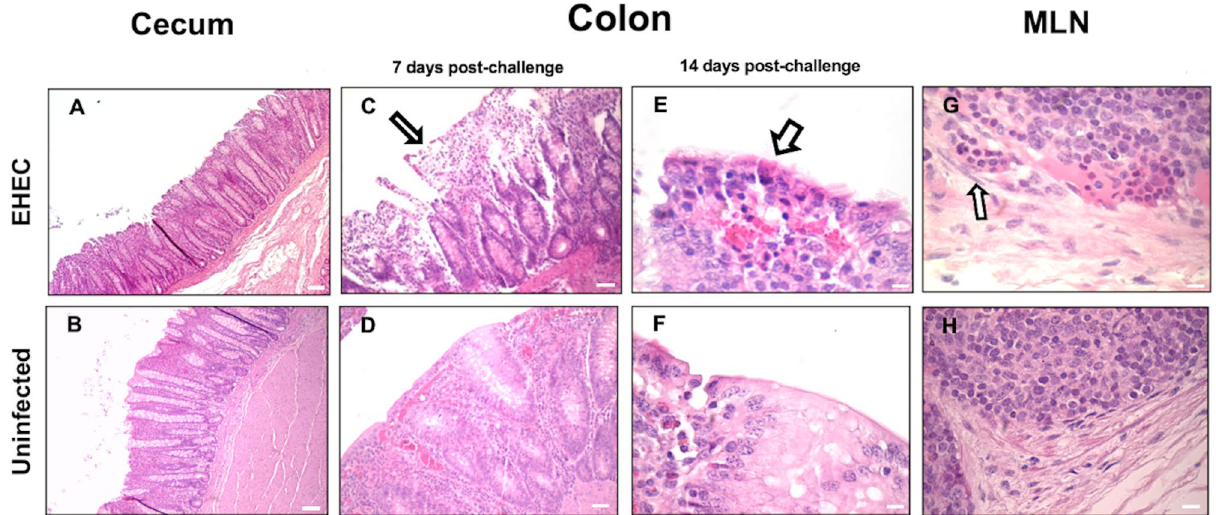
Figure 3. ( A-H ) Microphotographs (hematoxylin and eosin stain) of the cecum, colon, and mesenteric lymph node from calves infected by EHEC O157: H7 (EHEC) ( A, C, E, G ) and uninfected control calves ( B, D, F, H ). ( A ) Microphotograph of cecum from an infected calf with mild inflammation and disrupted epithelium and ( B ) from an uninfected calf (40x, bar = 100 µm). ( C ) Microphotograph of the colon with disrupted epithelium and subjacent cellular infiltrates (white arrow) at 7 d post-challenge (40x, bar = 100 µm) and ( D ) the corresponding uninfected control colon. ( E ) Microphotograph of colons of an EHEC O157: H7 infected calf at 14 d post- challenge with sub-epithelial congestion (400x, bar = 15 µm) and ( F ) from an infected calf. ( G ) Mesenteric lymph node with inflammatory cells infiltrating the subcapsular sinus (white arrow) in an EHEC O157: H7 infected calf at 7 d post-challenge and ( H ) mesenteric lymph node from a healthy uninfected calf (400x, bar = 15 (Fig. 3C) while uninfected calves showed no alteration (Fig. 3D). Moreover, infected calves showed neutrophils infiltrated in the subepithelium of colons at 14 d post-challenge (Fig. 3E) while uninfected calves had no lesions (Fig. 3F). Mesenteric lymph nodes in EHEC O157: H7 infected calves presented moderate hyperplasia of B and T zones, edema, and inflammatory cells infiltrating the subcapsular sinus (Fig. 3G) compared with unaltered mesenteric lymph nodes in uninfected calves (Fig. 3H). Inflammation in EHEC O157: H7 infected calves extended until RAJs, where the epithelium was detached with sloughing epithelial cells and neutrophil microabscess appeared under the epithelium at 7 d post-challenge (Fig. 4A). Uninfected calves displayed an intact RAJ epithelium (Fig. 4B). Levels of TLR4 mRNA in RAJ from infected calves at 7 and 14 d post-challenge were higher compared to the levels observed in uninfected calves, but with no difference between infected groups (7 versus 14 d) (Fig. 4C). Gene expression of IL8, IL10, and TNF α did not vary in RAJs of infected and uninfected calves (Fig. 4D). β-defensin LAP mRNA increased in RAJ of infected calves at 7 d post-challenge compared with uninfected calves and LAP mRNA levels decreased in infected calves at 14 d compared with 7 d post-challenge (Fig. 4E). Expression of cathelicidin BMAP28 and β-defensin TAP did not differ in RAJs of infected and uninfected calves (Fig. 4E). Early depletion in goblet cell and mast cell populations in colons of EHEC O157: H7 infected calves. Mucus producing goblet cells restricted to the bottom of the crypts in the colon of EHEC O157: H7 infected calves at 7 d post-challenge and they appeared in less number and poorly filled with mucus (Fig. 5A, Alcian blue) compared with uninfected colons (Fig. 5B) though the cell counting was not statistically different (Fig. 5C). Goblet cells in the cecum and RAJs were similarly present in number and distribution among the groups. (data not shown). WGA lectin can bind oligosaccharides containing terminal N-acetylglucosamine (α-D-GlcNAc and NeuNAc) present in all cell membranes although these carbohydrates are abundantly expressed in mucus-producing goblet cells. These WGA + glycans were abundant in the intestinal mucin layer of uninfected calves, showing filled round shape like- goblet cells and a continuous thin layer in ileum, cecum, colon, and RAJ (Fig. 6A). In EHEC O157: H7 infected calves, a discontinuous mucin layer pattern was observed where WGA lectin + mucin containing goblet cells were dispersed in numbers and had a variable grade of filling across ileum, cecum, colon, and RAJ (Fig. 6B). In stark contrast, RAJs in calves at a later time of EHEC O157: H7 infection (14 d post-challenge) had exaggerated WGA mucin expression with filled goblet cells and a thick mucin layer (Fig. 6B). The number of mast cells reduced in ileal and cecal mucosal lamina propria of EHEC O157: H7 infected calves at 7 and 14 d post-challenge, although no difference was observed in the number of submucosal mast cells (Fig. 7, Sup Fig. 1). In RAJs, the number of submucosal mast cells decreased at 7 d post-challenge compared with the number of those cells in uninfected calves (Fig. 7, Sup Fig. 1). We observed the number of mast cells in the submucosa of colons in EHEC O157: H7 infected calves at 14 d post-challenge was higher compared with the number of those cells in calves infected at 7 post-challengee (Fig. 7, Sup Fig. 1).